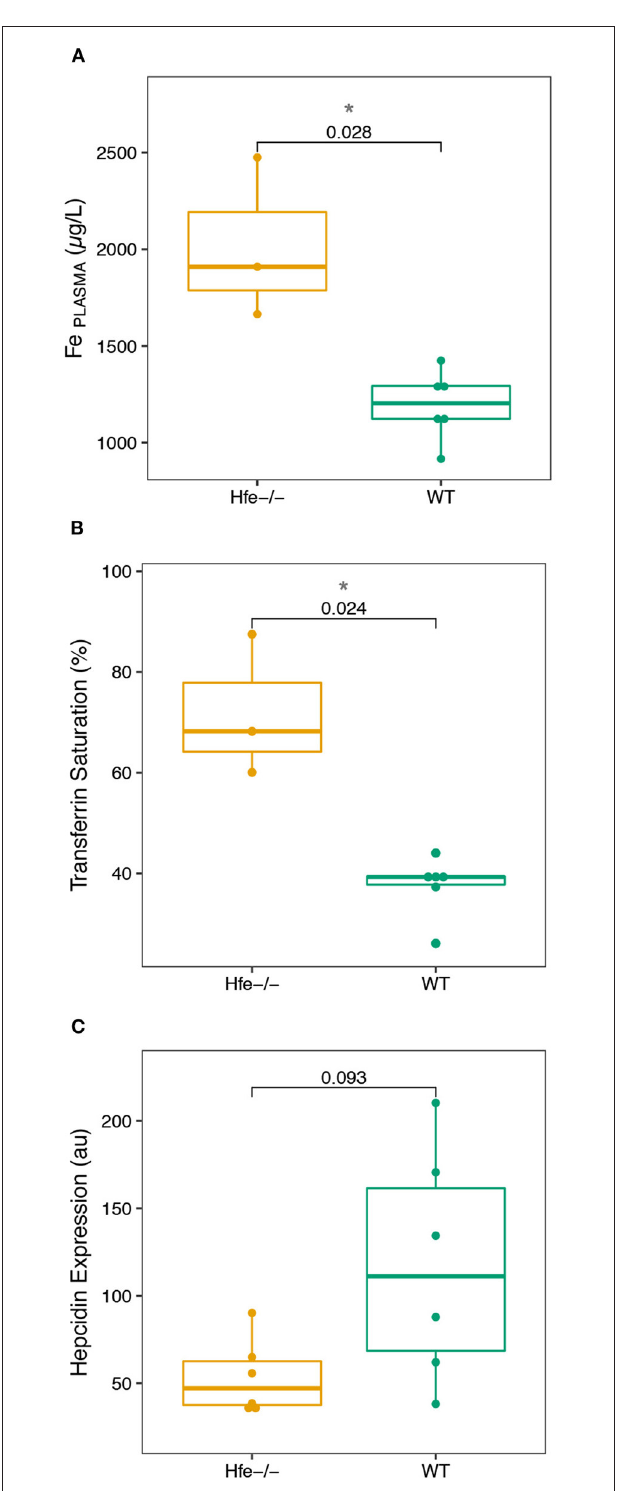
FIGURE 1 | Boxplots of the biological parameters commonly investigated in hereditary hemochromatosis disease measured in the H fe − / − mouse model and compared to the WT group. (A) , Fe plasma concentration. (B) , Transferrin Saturation. (C) , Hepcidin Expression. The P -values of Wilcoxon test and associated significance (*** P < 0.001, ** P < 0.01, * P < 0.05) are